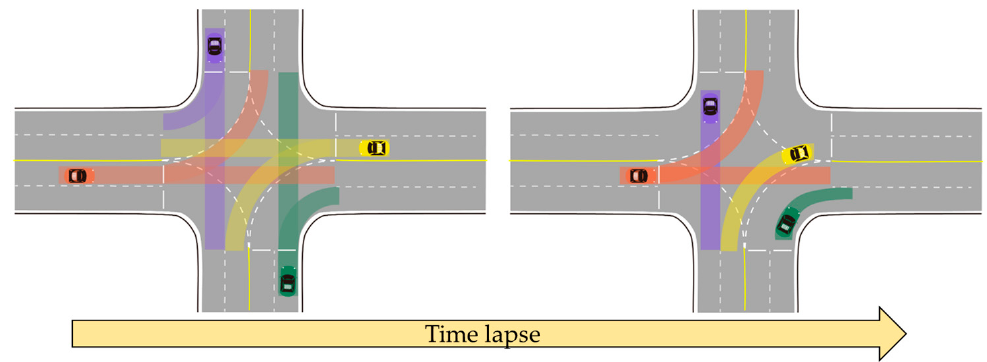
Figure 3. Projecting the vehicle onto the digital map.